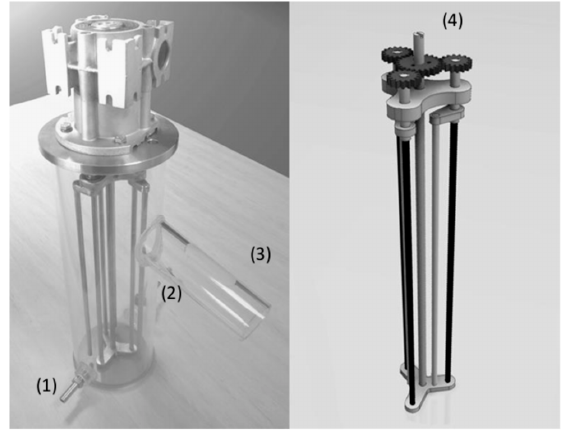
Figure 2. Experimental configuration showing the (1) suspension inlet, (2) polymer sparge positioned diametrically opposite the suspension inlet, (3) suspension outlet, and (4) planetary gearing system for the vertical rods used in the chaotic mixer.